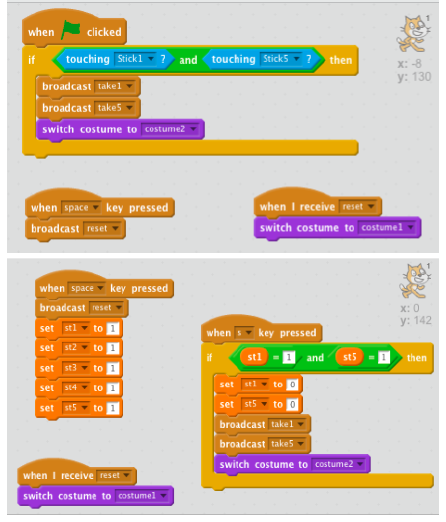
Fig. 2 Two representations of the fork taking: Above, using broadcast only and the second; below, using variables to represent the states of the fork. On Greenfoot, we created 5 versions of the game. These versions varied according to how we defined the actors, if using one philosopher class (actor) with different images or multiple classes (actors); adding a restriction to fork’s behavior to guarantee that the fork is taken and it is taken by only one actor; using a different method available to check if the fork was taken than it was used in the initial version; and changing the order of definition of actors and their placement in the environment (world). The first 4 versions we mentioned did not affect the result. It was only by changing the actors positioning order that we could see a change in the result of the game (Fig. 3). This allowed us to infer, later, the concurrent behavior of the Dining Philosophers on